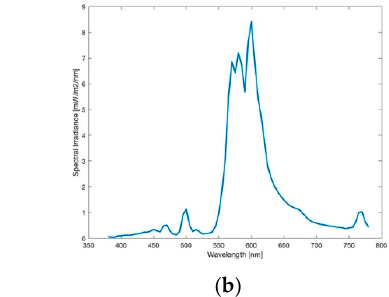
Figure 1. ( a ) Image of the High Pressure Sodium (HPS) lamp during daytime; ( b ) Spectrum of lamp observed.